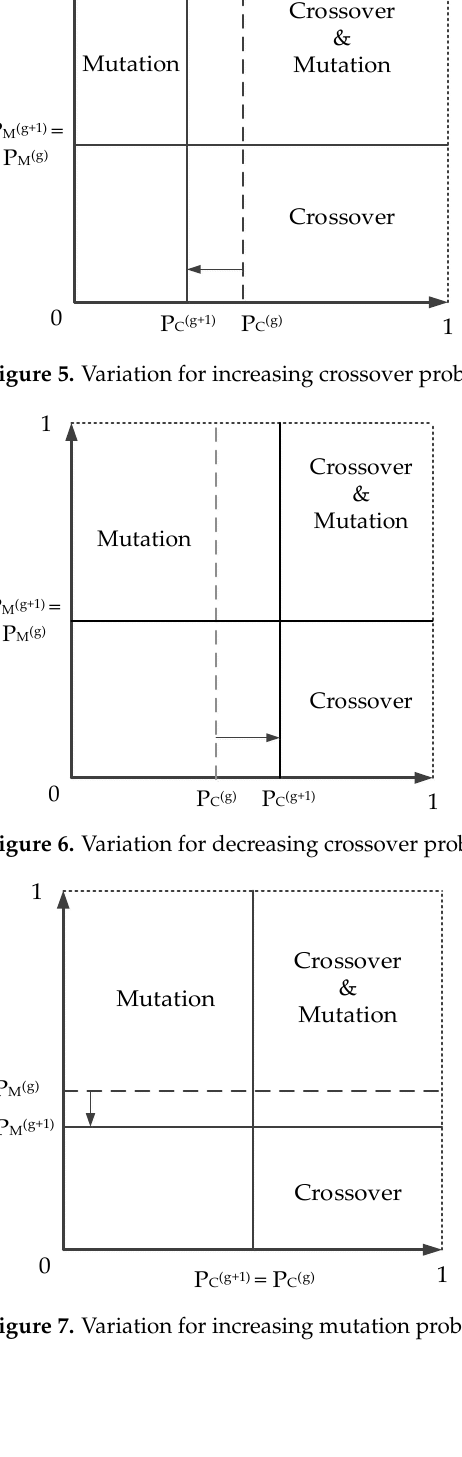
Figure 8. Variation for decreasing mutation probability. 3.4. Tabu List A tabu list is introduced in order to avoid forbidden moves, such as 